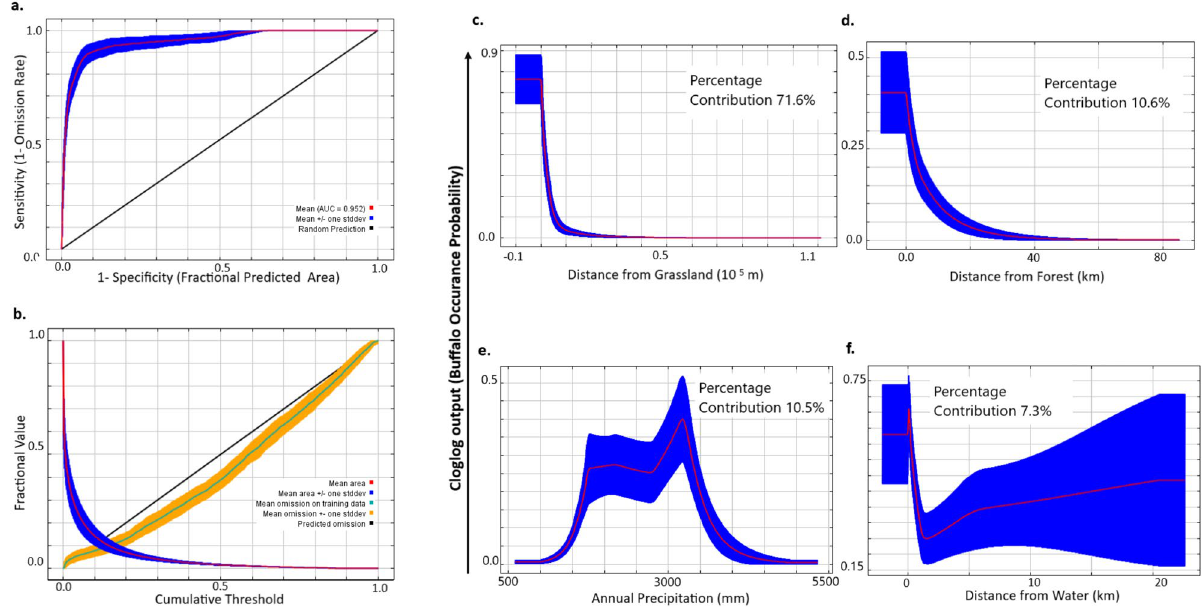
Figure 2. ( a ) Receiver Operator Curve for assessing model fit, ( b ) Omission/Commission analysis for model accuracy of classifying test data. Response curves obtained from 100 bootstrap runs of modeling distribution of wild swamp buffalo in Maxent to ( c ) distance to grassland, ( d ) distance to forest, ( e ) Annual precipitation and ( f ) distance to water for the Terai-Brahmaputra floodplains